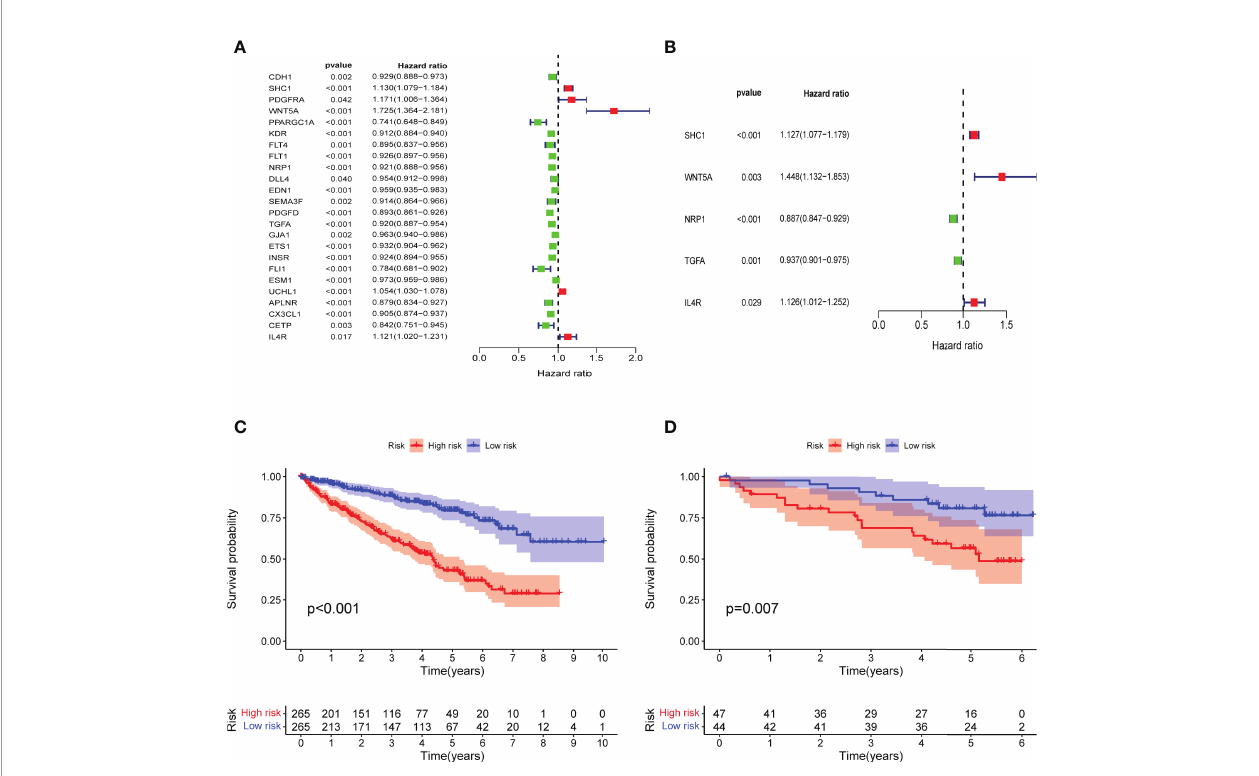
FIGURE 3 | Construction of IRPDGs and prognosis of different IRPDGs subgroups. (A) Univariate Cox analysis of 24 immune-related hub genes. (B) Five genes are independently and signi fi cantly associated with ccRCC prognosis. (C) K – M survival analysis of the IRPDGs subgroups in the TCGA cohort. (D) K – M survival analysis of the IRPDGs subgroups in the ICGC